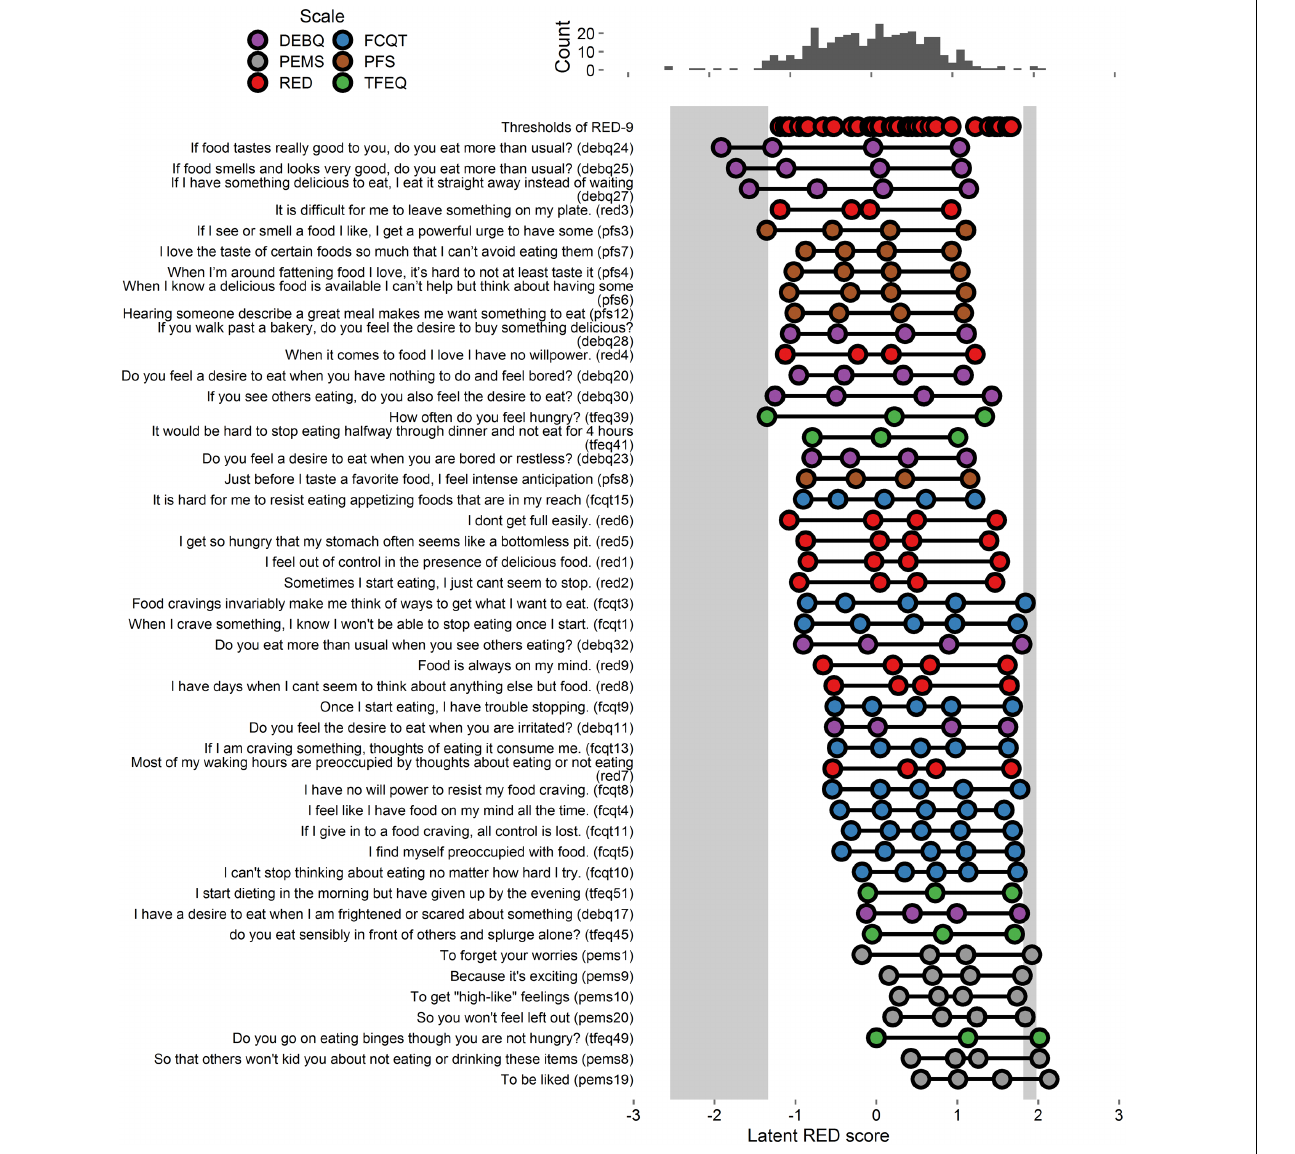
FIGURE 2 | Person-item map and histogram depicting thresholds on the spectrum of RRE for Study 2. See Figure 1 note. Some items are shortened for graphical presentation. This figure includes the RED-9 items and the 37 items that account for variance in the gap areas. See Supplementary Figure S2 for a figure with all items